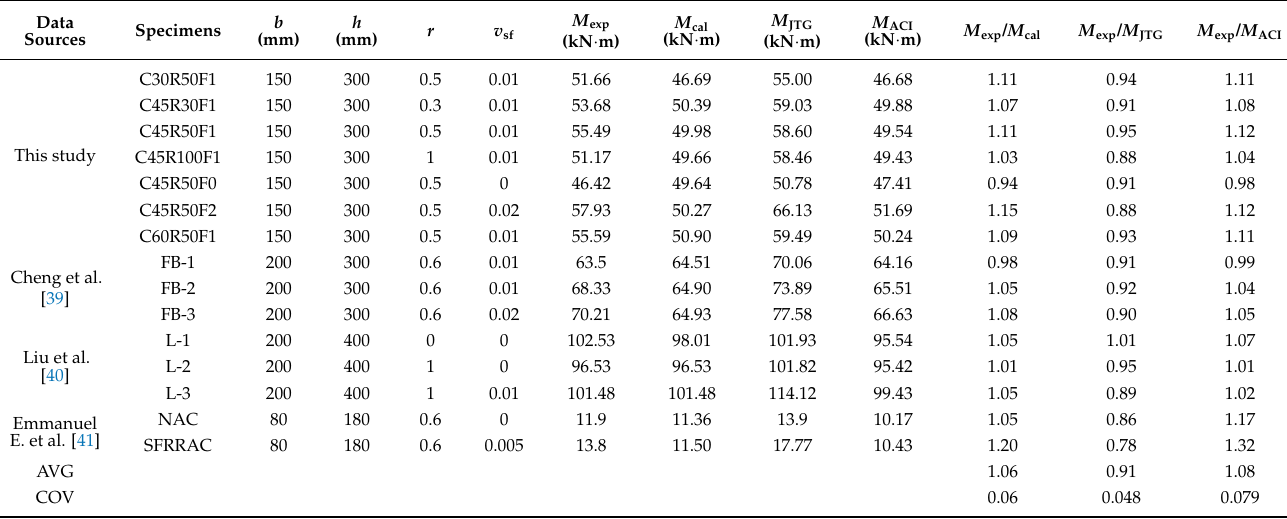
Table 5. Comparisons of the flexural bearing capacity of SFRAC.